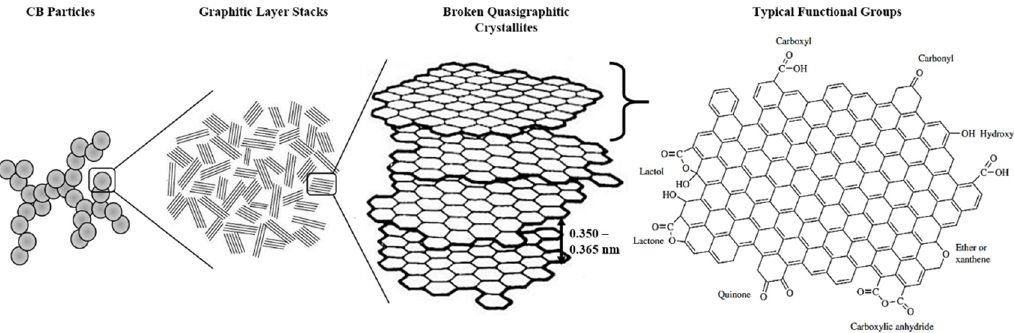
Figure 3. Structure of CB and its typical surface functional groups. Adapted with permission from [36]. Copyright 2003 John Wiley & Sons.